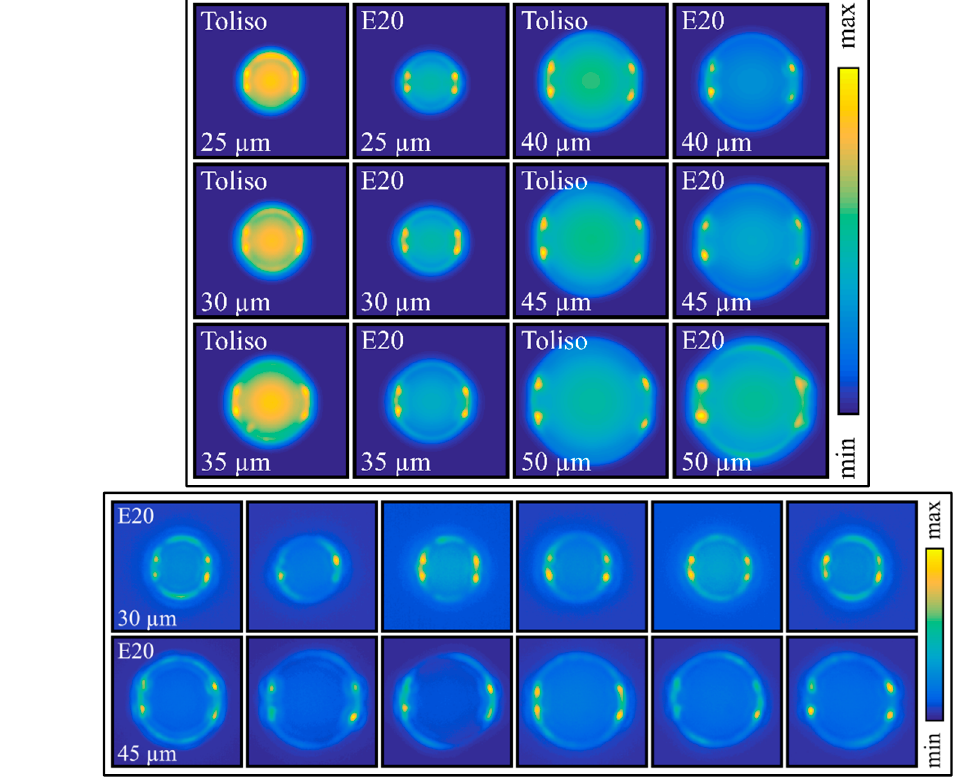
Figure 7. ( a ) Bin-wise averaged LIF signals ( d droplet ± 0.25 µm) of micro droplets in diameter in a range of 25 µm to 50 µm at reference conditions (293 K, nile red 100 mg/l). The intensity was normalized to the respective maximum signal. ( b ) Single -hot fluorescence images for 30 µm and 45 µm droplets (E20) exhibiting MDR.